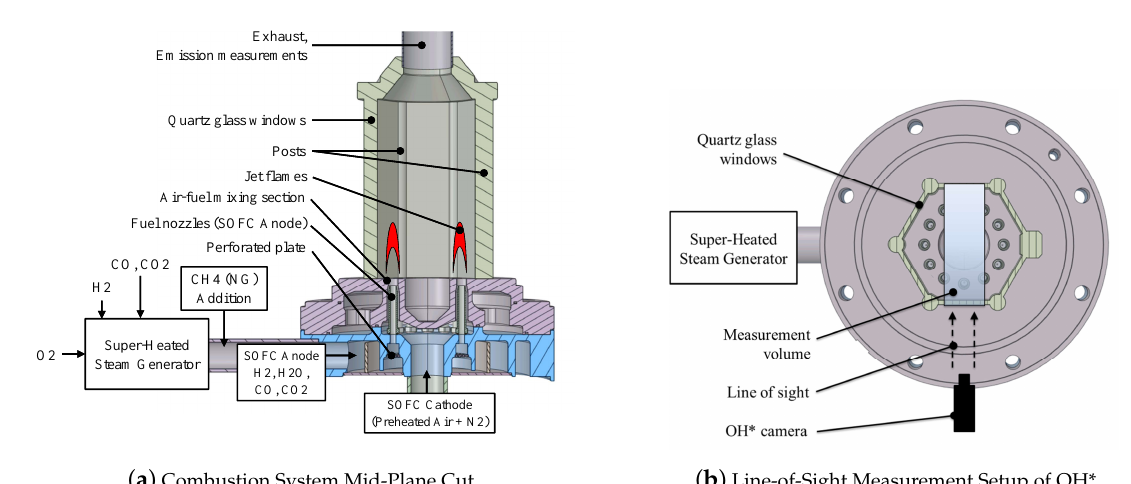
Figure 1. The low-calorific burner system, F20OG.1, with upstream heat generator system (solid oxide fuel cell (SOFC) emulator), combustion chamber components, and measurement techniques